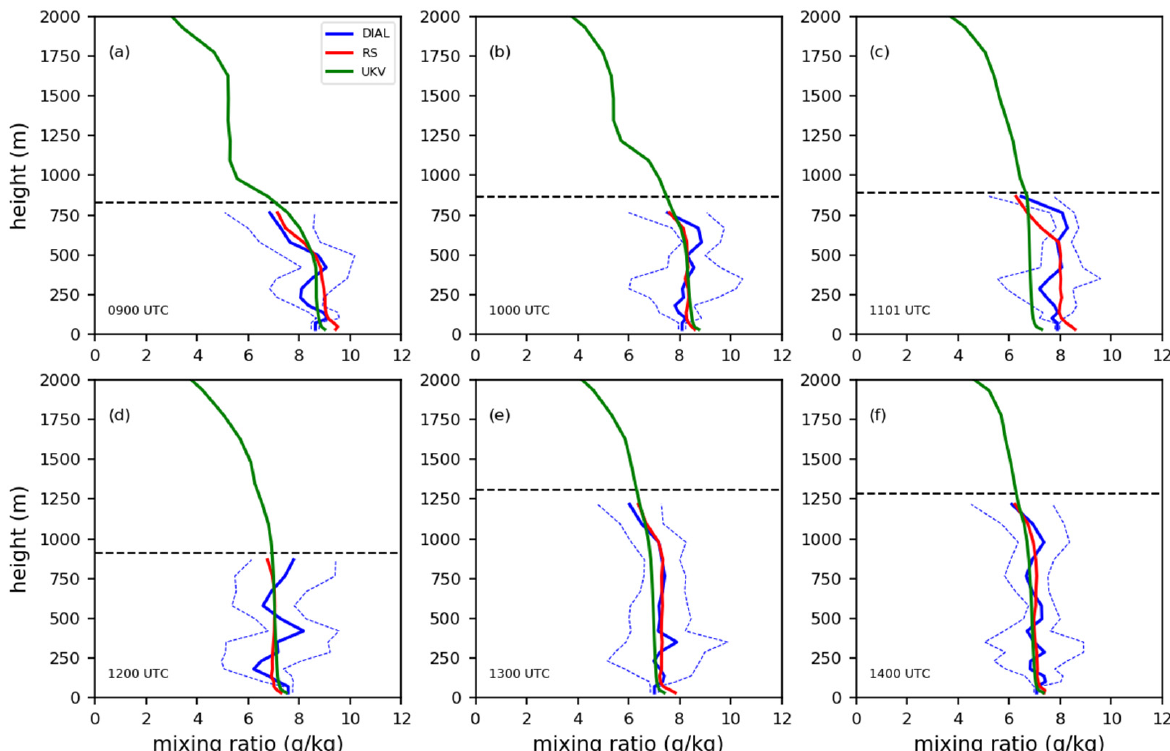
Figure 14. Water vapour mixing ratio profiles from BB-DIAL, radiosonde and UKV model background 09:00–14:00 UTC, 14 July 2020. The horizontal dashed line represents the maximum height from the Vaisala algorithm. ( a ) 09:00 UTC, ( b )10:00 UTC, ( c ) 11:00 UTC, ( d ) 12:00 UTC, ( e ) 13:00 UTC, ( f ) 14:00 UTC